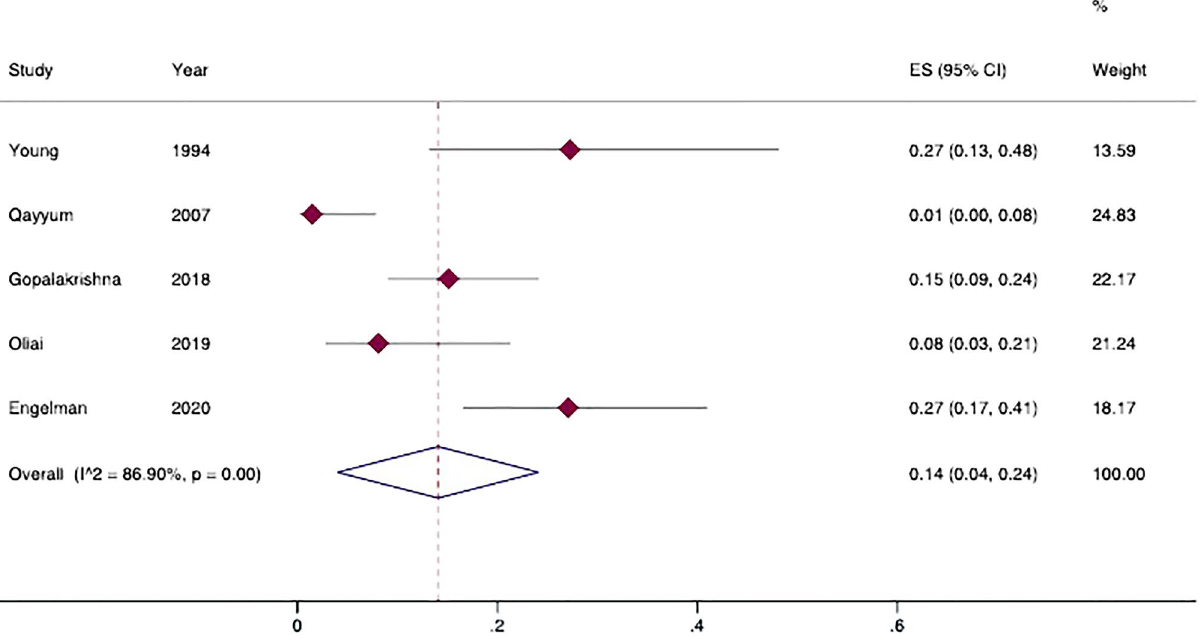
Figure 3. Prevalence of splenomegaly in patients with pseudocirrhosis. Forest plot of overall pooled prevalence of splenomegaly (random effect model); data from observational studies. 95%CI: 95% Confidence Intervals; ES: effect size; I 2 : heterogeneity.